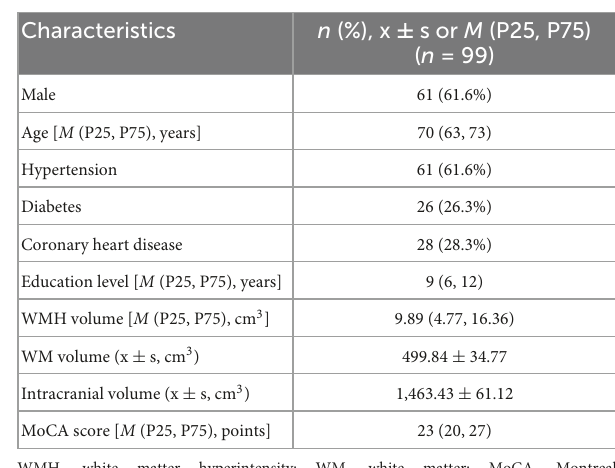
TABLE 1 Baseline